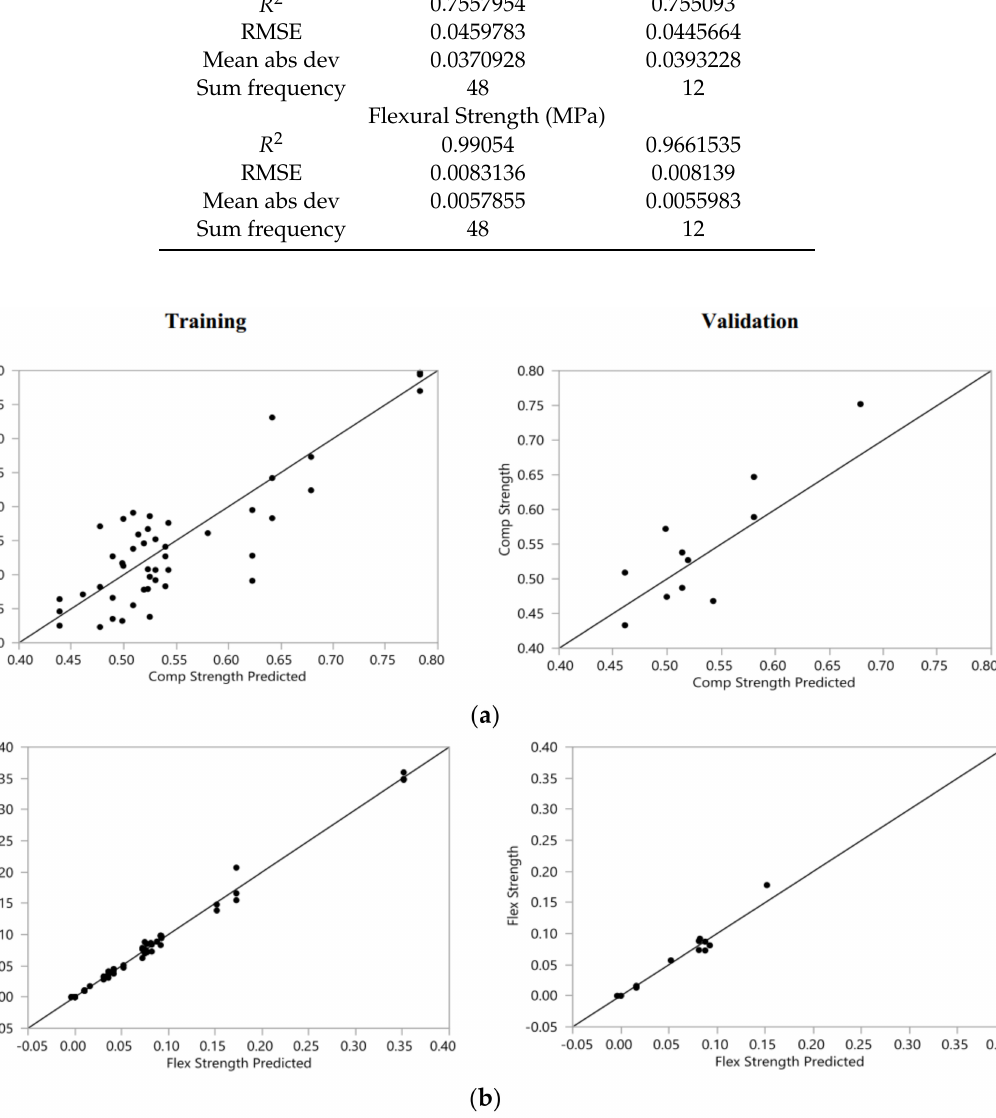
Figure 11. Training and validation plots for ( a ) compressive strength and ( b ) flexural